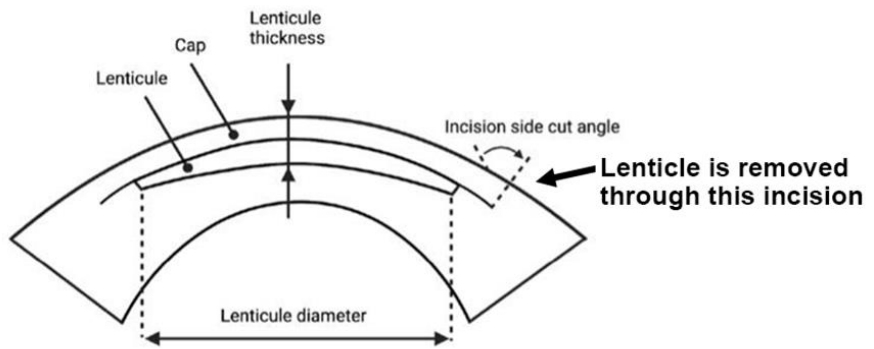
Figure 3. SMILE, a lenticule-based procedure. Side view of the lenticule profile and lenticule re- moval via the small incision (bold arrow) (Figure created using BioRender.com, Toronto, ON, Can-